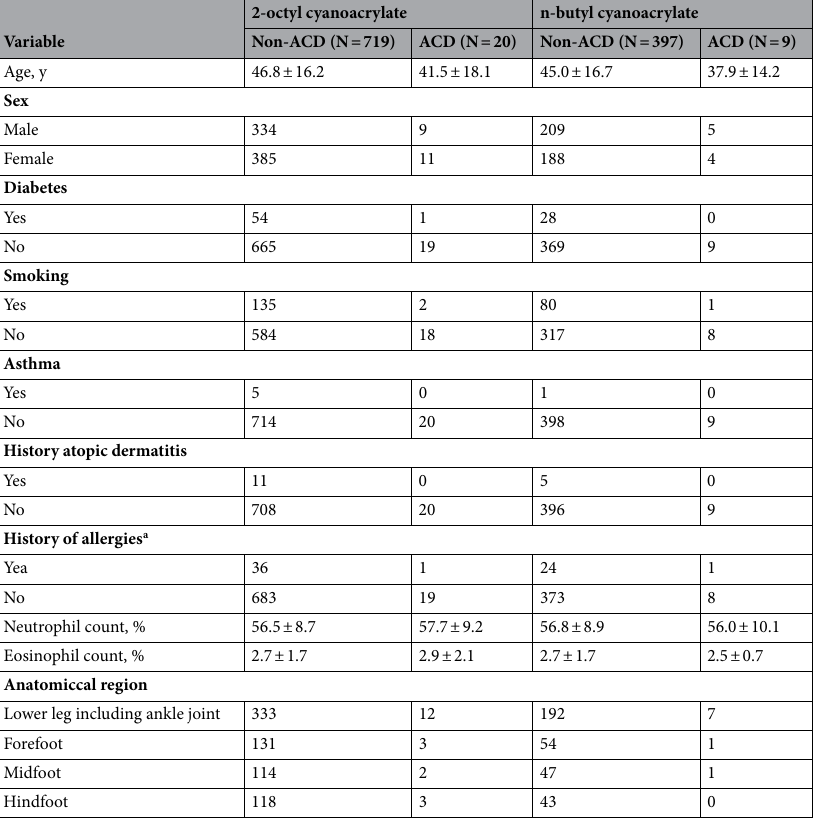
Table 1. Patient demographics. Data are mean ± standard deviation or number of patients (%). ACD allergic contact dermatitis. a Antigens other than topical skin